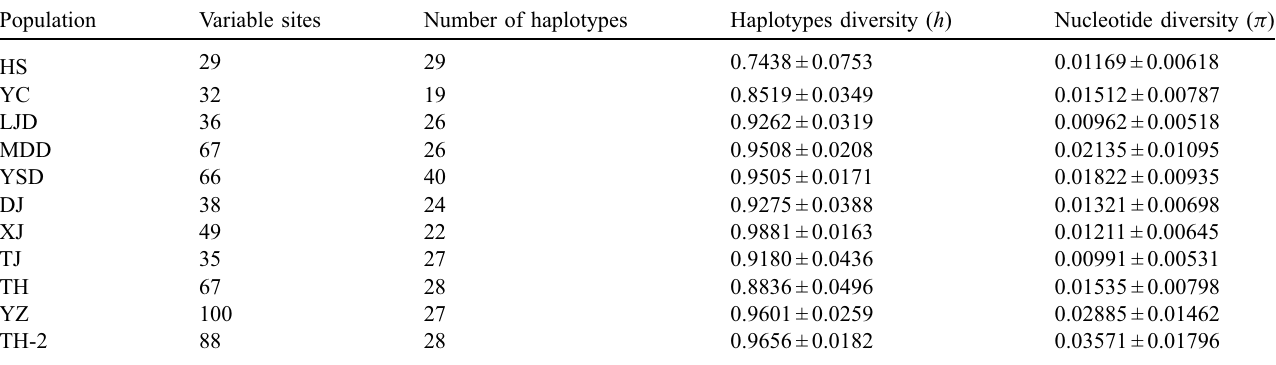
Table 2. Genetic diversity parameters of 11 M. nipponense